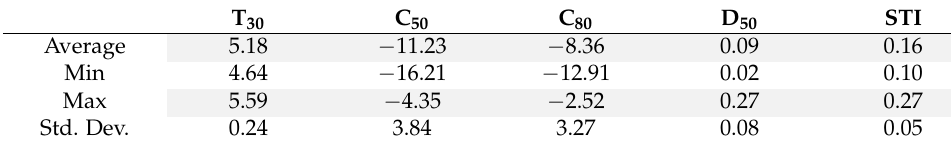
Figure 12. A contemporary external view of the Dome of Conegliano. Table 2. Averaged acoustic parameter results at mid-frequencies—Source in position 1.